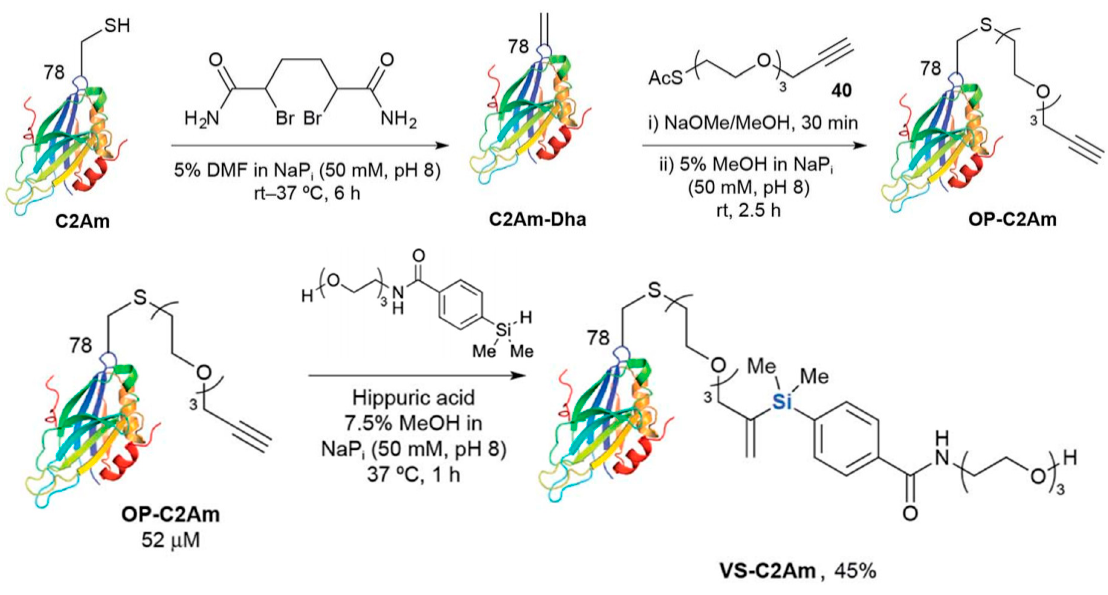
Figure 32. The application of a combination of Hs and Ht reactions for the addition of an organosilicon derivative of hippuric acid to synaptotagmin. Republished with permission of Royal Society of Chemistry, © 2017, from Ref.